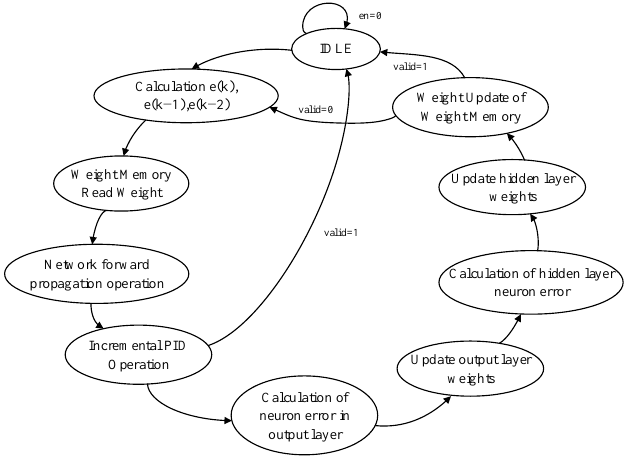
Figure 14. The main state machine diagram of the BP neural